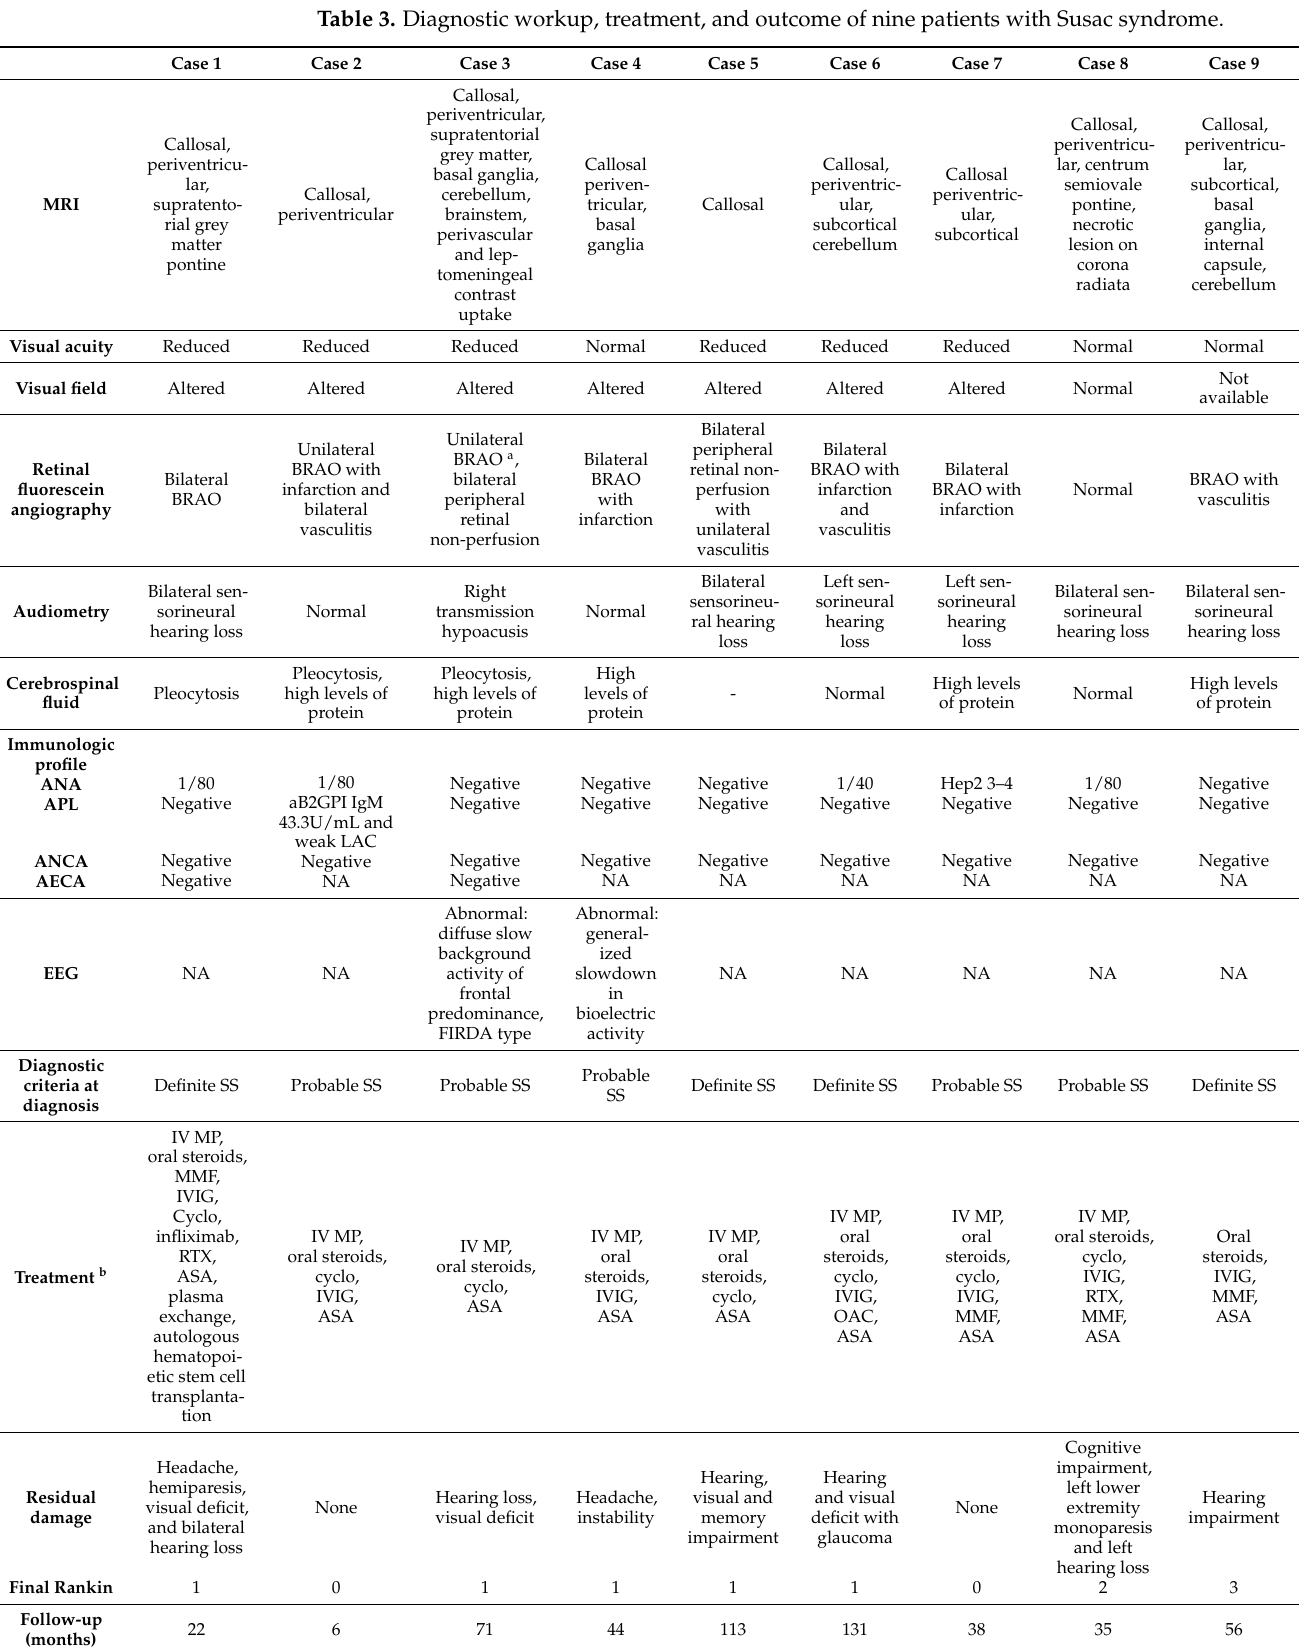
Table 3. Diagnostic workup, treatment, and outcome of nine patients with Susac